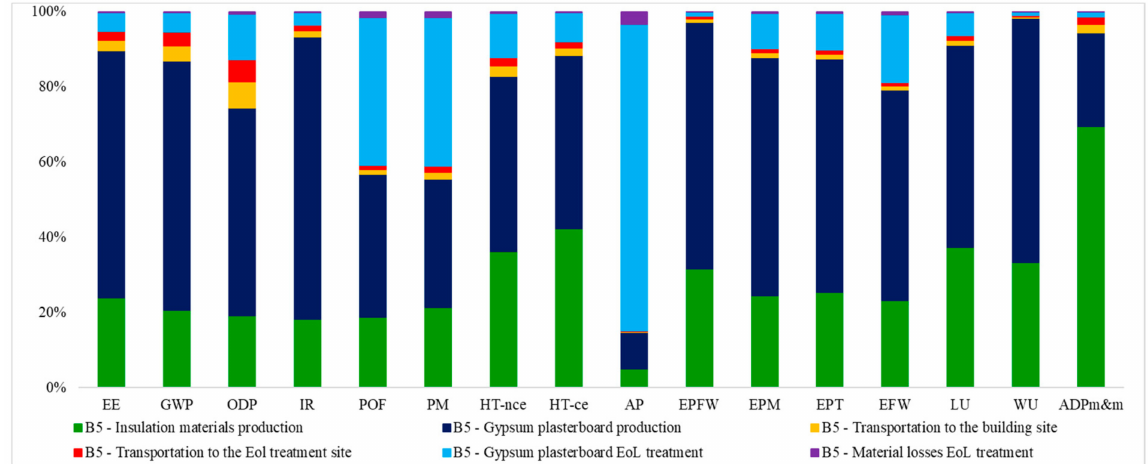
Figure 4. Contribution of the different life cycle phases to the B5 module impacts—CfS (1945–1969).